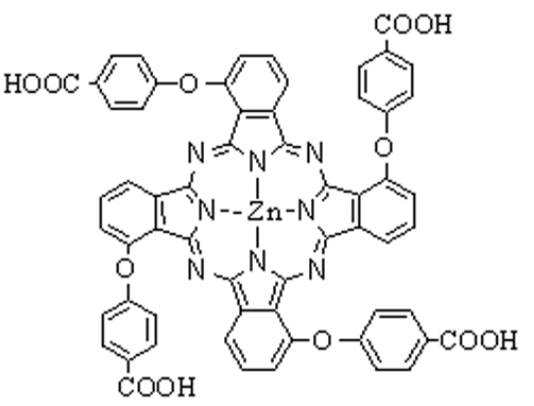
Figure 1. Chemical structure of T α